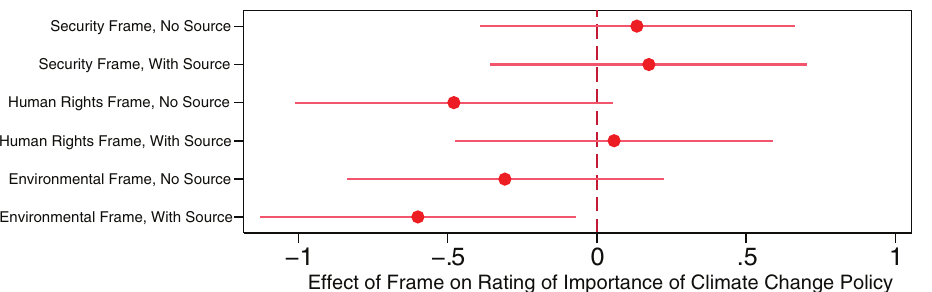
Fig 1. Climate change frames and ratings of the importance of climate change policy. Note: Horizontal bars indicate90% confidenceintervals.